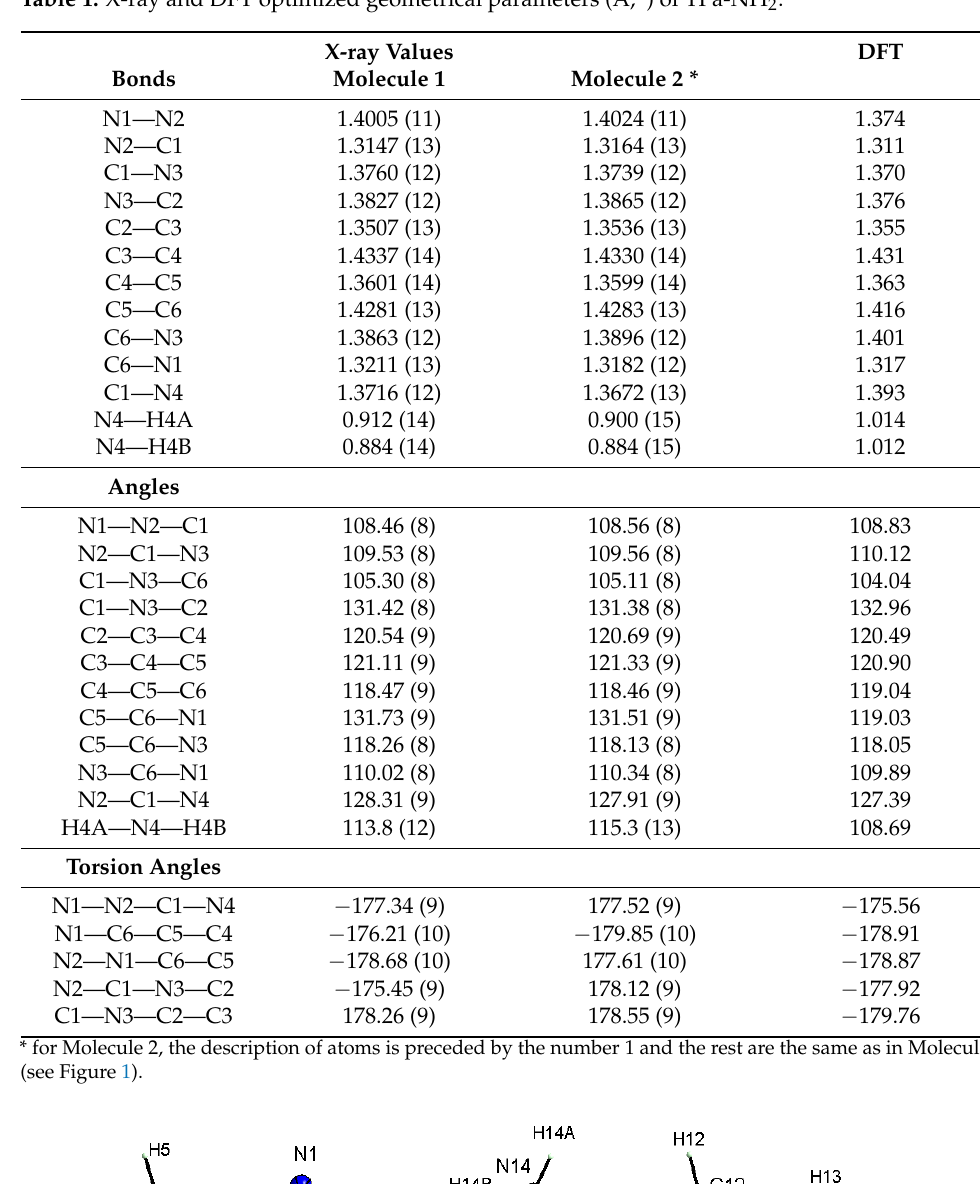
Table 1. X-ray and DFT optimized geometrical parameters (Å, ◦ ) of TPa-NH 2 .